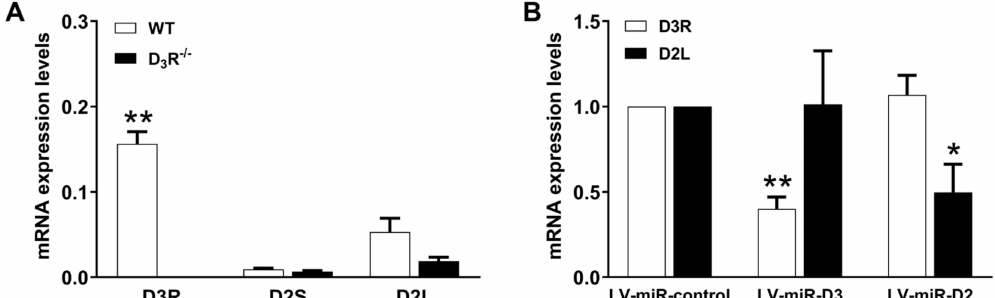
Figure 4. ( A ) Levels of mRNA encoding D3R and D2R (short- and long-splice variants, D2S, D2L) in aortic segments from wild-type (WT) and D3R − / − mice. Total RNA was reverse transcribed; the corresponding cDNA was quantitated by real-time PCR. Levels of mRNA are normalized against the housekeeping gene GAPDH. Each column (with vertical bars representing standard errors) represents the average from 7–15 different RNA samples. Two-way ANOVA, (genotype: F (1,59) = 75.2, p < 0.0001; mRNA expr.: F (2,59) = 37.29, p < 0.0001; genotype × mRNA expr. F (2,59) = 46.88, p = 0.0001) and Bonferroni’s test (** p < 0.01 vs. D2S and D2L). ( B ) Levels of mRNA encoding D3R and D2R in aortic segments from wild-type treated with lentiviral vectors, delivering synthetic miRNA (LV-miR-control, scrambled sequence; LV-miR-D3, targeting D3R; LV-miR-D2, targeting D2R). Total RNA was reverse transcribed; the corresponding cDNA was quantitated by real-time PCR. Levels of mRNA are normalized against the housekeeping gene GAPDH and the mRNA receptor expression in LV-miR-control. Each column (with vertical bars representing standard errors) represents the average from 5–9 different RNA samples. Two-way ANOVA, (LV-miR: F (2,30) = 2.21 p = 0.12; mRNA expr.: F (1,30) = 0.01, p = 0.90; LV-miR × mRNA expr. F (2,30) = 9.39, p = 0.0007) and Bonferroni’s test (* p < 0.05, ** p < 0.01 vs.